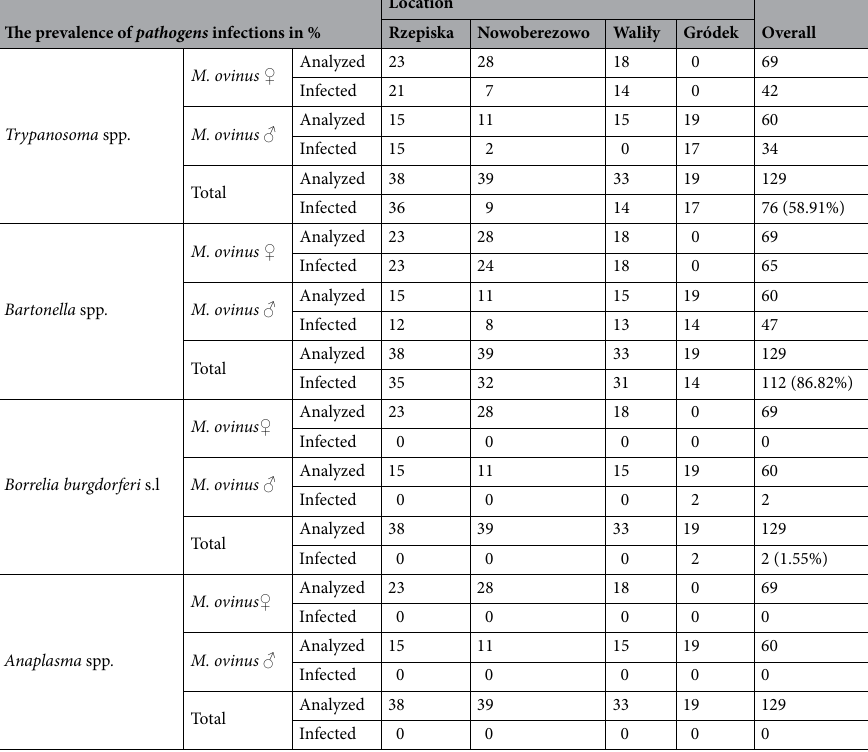
Location OverallRzepiska Nowoberezowo Waliły Gródek